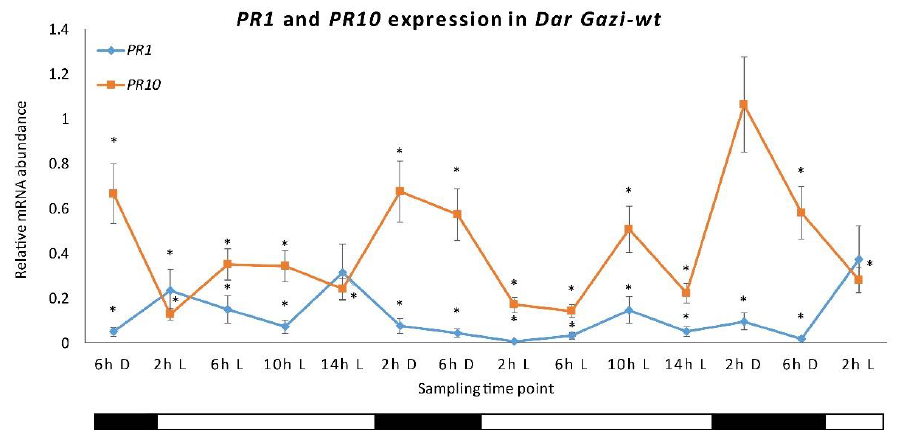
Figure 4. PR1 and PR10 expression in Dar Gazi-wt. The results are presented after normalization with ef1A . The average was generated by two biological replicates run in triplicate. Error bars represent SD. Within the sampling time point, the asterisk indicated a statistically significant difference compared to the highest values of each gene (Student’s t -test, p ≤ 0.05). The bars under the horizontal axis show the light and dark periods,